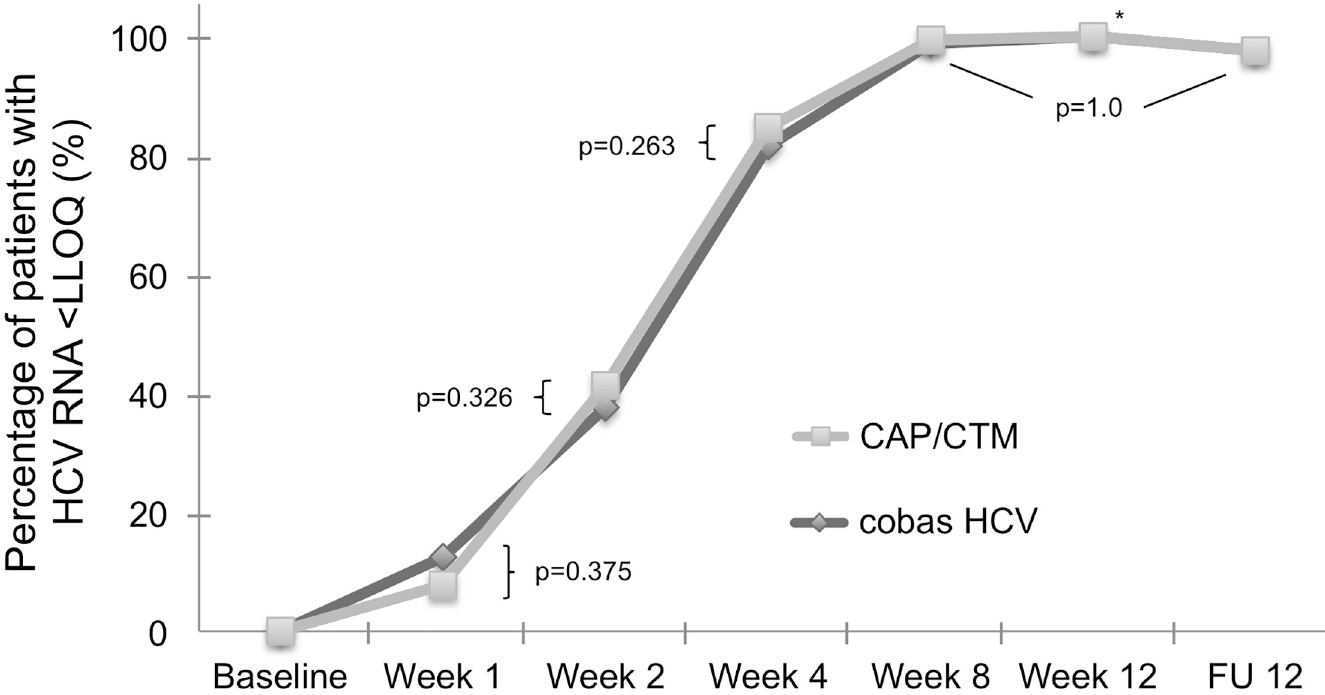
Fig 2. Virologic responses at week 1, week 2, week 4, week 8, week 12 and 12 weeks after the end of treatment (FU12) according to cobas HCV and the CAP/CTM. There was no significant difference between the two assays. � As there are no discordant pairs, p-value cannot be